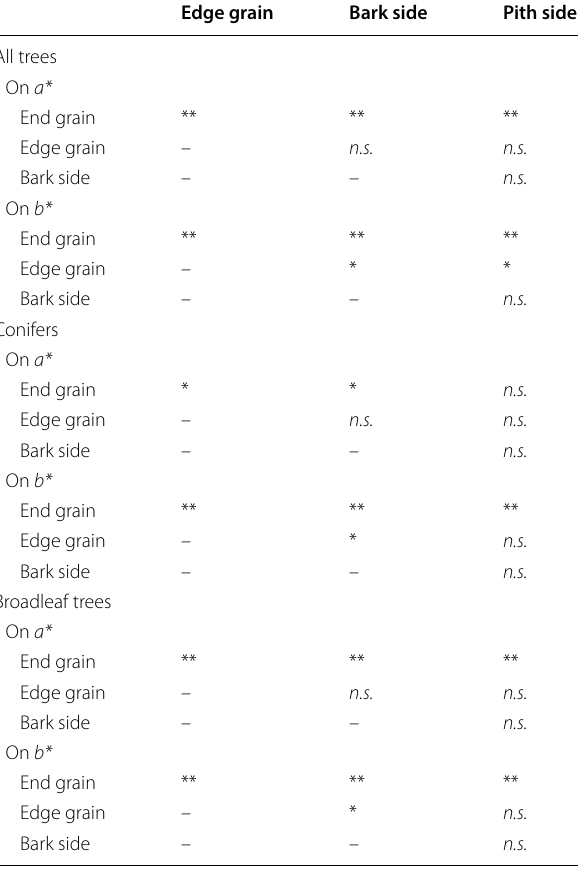
Table 5 Paired t test results of differences between each measuring plane on a* and b* in Fig.